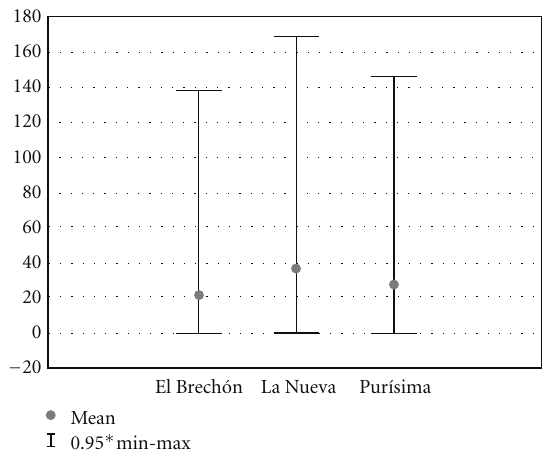
Figure 5: Box and whisker plot for chargeability (induced polarization, IP).